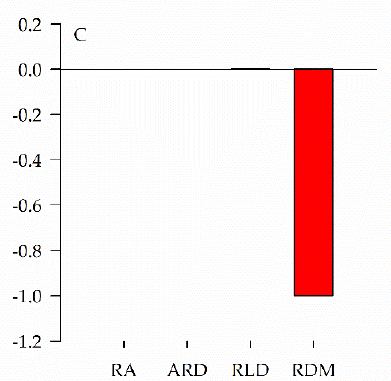
Figure 3. Loadings of variables in Yield components ( A ), Physiological traits ( B ), Root development